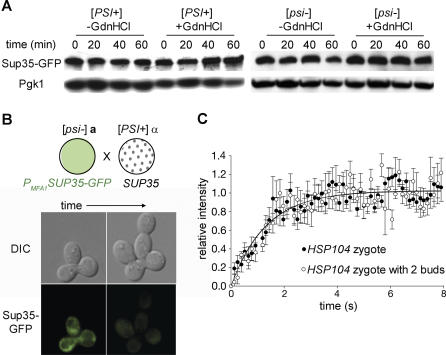
Loss of Sup35-GFP[PSI+] Fluorescence in Wild-Type Cells Corresponds to Redistribution of Existing Fusion Protein to New Prion Complexes(A) The metabolic stability of Sup35-GFP was analyzed in [PSI+] (SY81) or [psi−] (SY87) yeast lysates upon inhibition of new protein synthesis with cycloheximide. An anti-Sup35 immunoblot is shown along with an anti-Pgk1 immunoblot of the same membrane as a control for loading.(B) Shown are representative images (n = 7) of a wild-type zygote (SY360 × SY581) constitutively expressing untagged SUP35 from its endogenous locus (left image) and of the same zygote following the formation of a second daughter and first granddaughter (right image). The Sup35-GFP in these cells is that existing at the time of mating as described in Figure 2A.(C) FRAP recovery curves for a wild-type zygote (SY360 × SY581; black circles) and its daughter (white circles), as described in (B), are shown. The respective recovery times are 0.92 s (R2 = 0.85) and 0.95 s (R2 = 0.84).